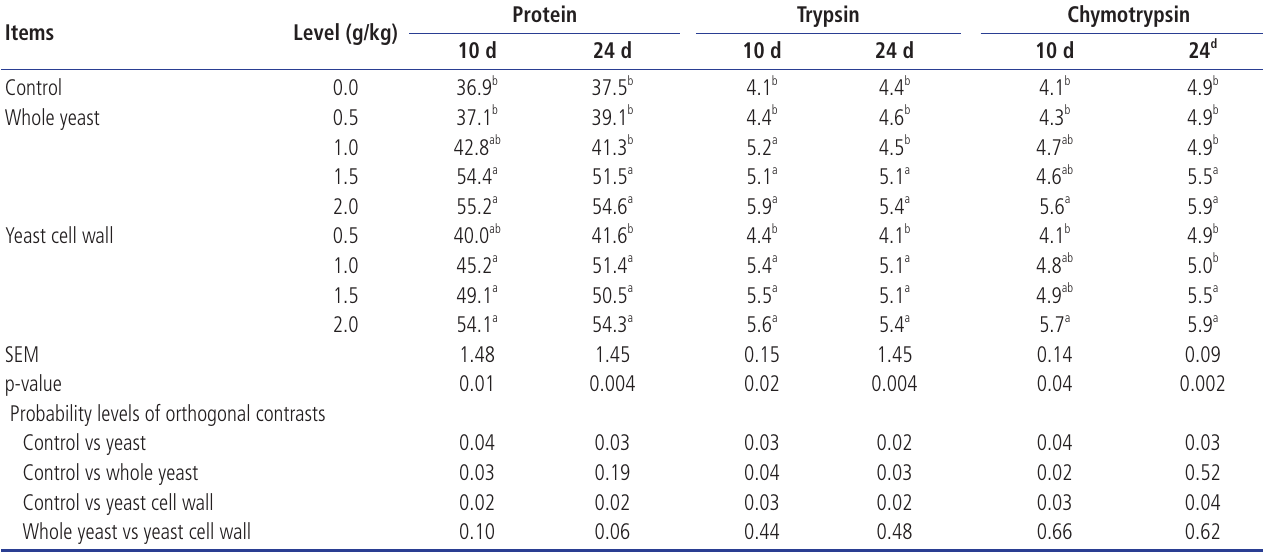
Table 5. Effects of dietary treatments on protein concentration (mg/g tissue) and pancreatic enzyme activity (μmol/mg protein/min) of broilers at 10 and 24 d of age